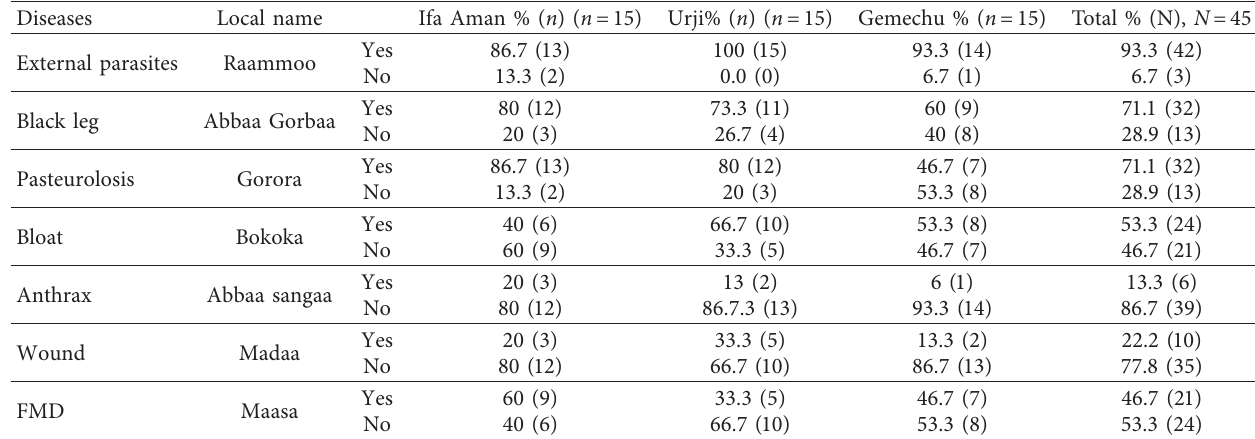
Table 3: Major diseases affecting beef cattle in the selected three kebeles of Doba district.